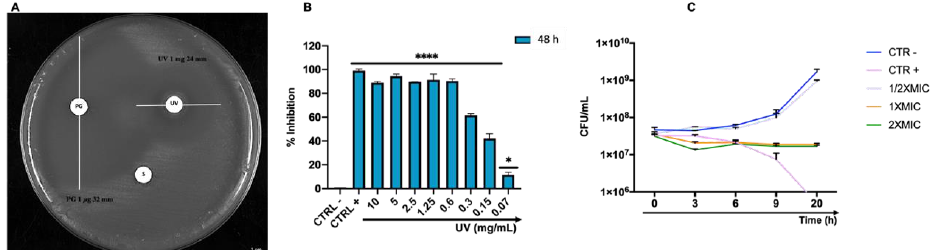
Figure 4. (A ) Diameter of the inhibition area exhibited by C. acnes ATCC 11182 after exposure with Arctostaphylos uva-ursi leaf extract (1 mg); piperacillin (1 µ g) was used as antibiotic control (PG) while H 2 O as solvent control (S); ( B ) growth inhibition rate (%) of C. acnes after Arctostaphylos uva-ursi leaf extract treatment; ( C ) time-kill kinetics assay; CTRL − : bacteria treated with the solvent used to dissolve the drug; CTRL +: bacteria treated with vancomycin (10 µ g/mL). Data represent the mean ± standard deviation (SD) of three independent experiments; ****: p -value< 0.0001; *: p -value = 0.0475. ANOVA: p -value < 0.0001, R squared =